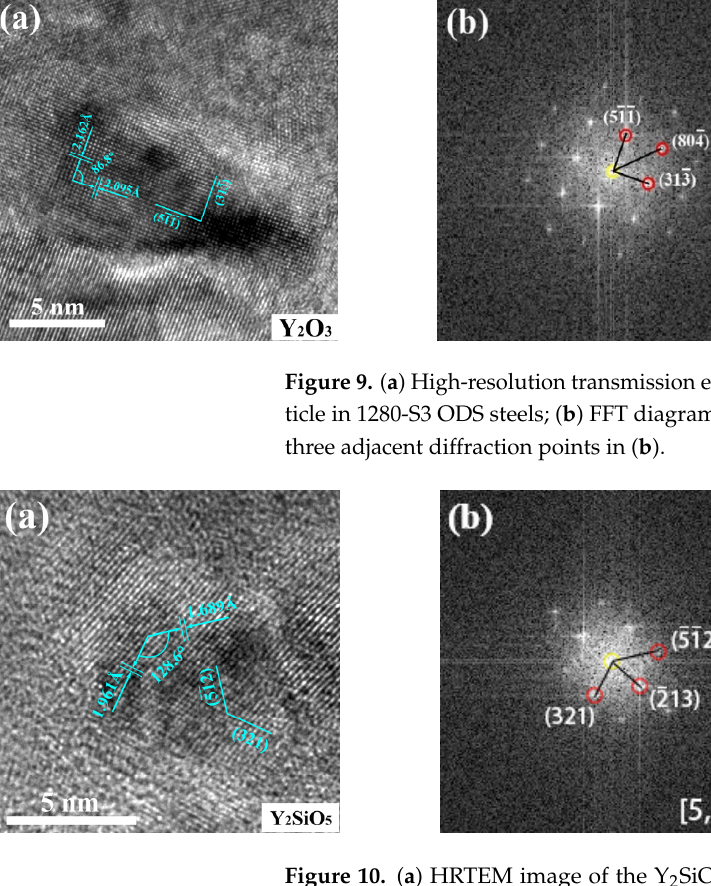
Figure 11. ( a ) HRTEM image of the Y 2 Si 2 O 7 nanoparticle in 1280-S3 ODS steels; ( b ) FFT diagram micrograph by ( a ); ( c ) IFFT filtered image derived from three adjacent diffraction points in ( b ). 3.2.4. The Influence of Different Si Content on the Mechanical Properties of ODS Steels The Vickers hardness distribution of ODS steels with different Si content at 1280 °C and 1300 °C is shown in Figure 12. For both sintering temperatures, the hardness of ODS steels gradually improved with Si content increasing. The 1280-S3 and 1300-S3 ODS steels were the hardest (442.33 HV, 425.33 HV).